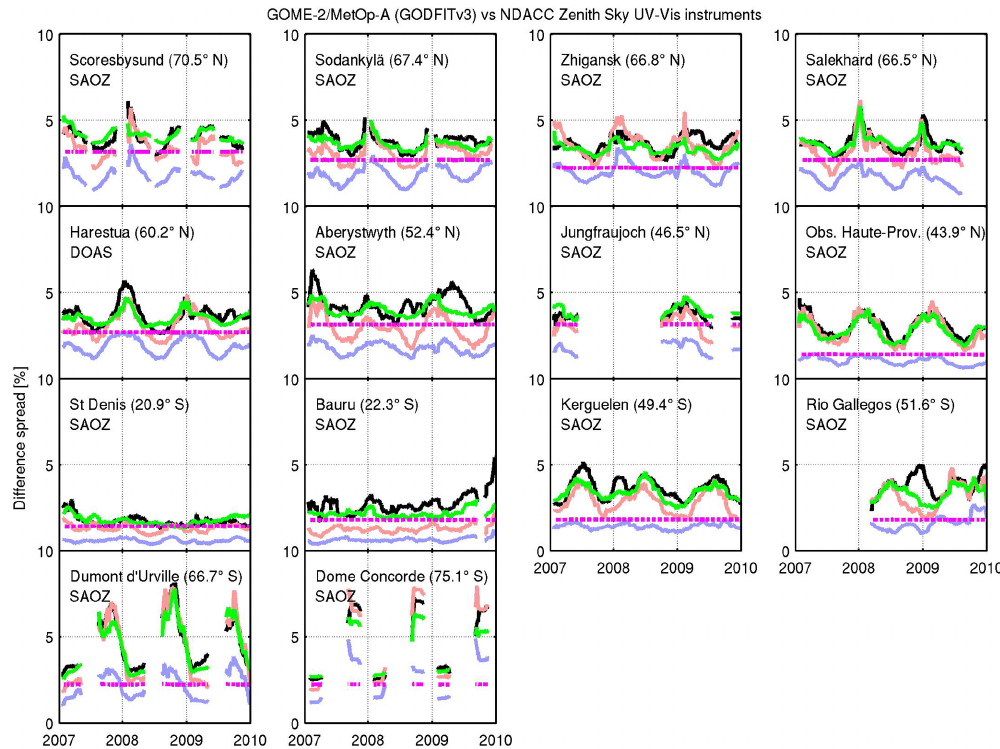
Figure 16. Similar to Fig. 14 but now for all NDACC UV-Vis (ZSL-DOAS) instruments with sufficient